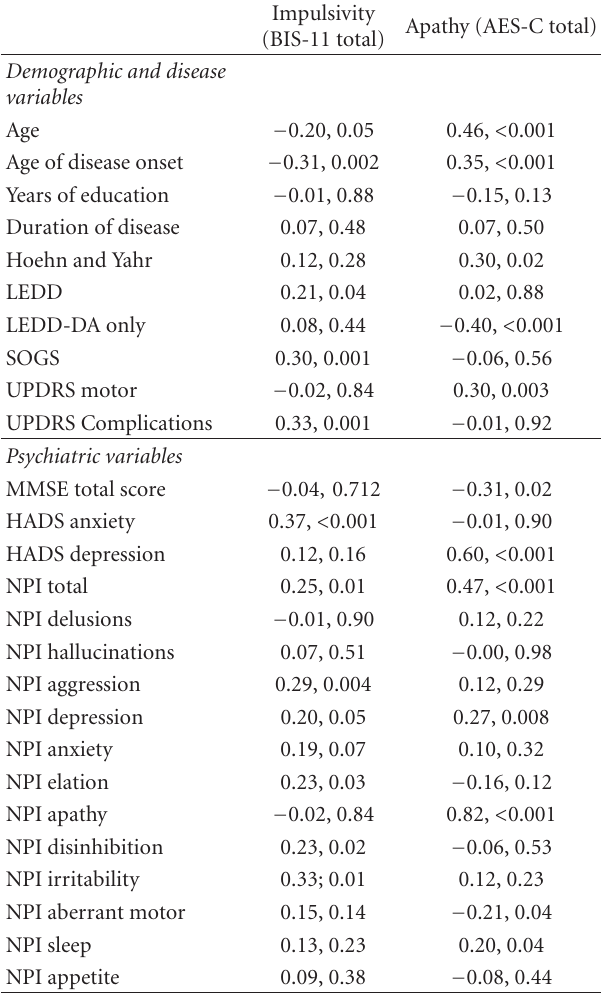
Table 4: Correlations Pearson/Spearman’s rho ( ρ , upper value; P , lower value) between impulsiveness (BIS-11) and apathy (AES-C) and key variables for the entire study group.